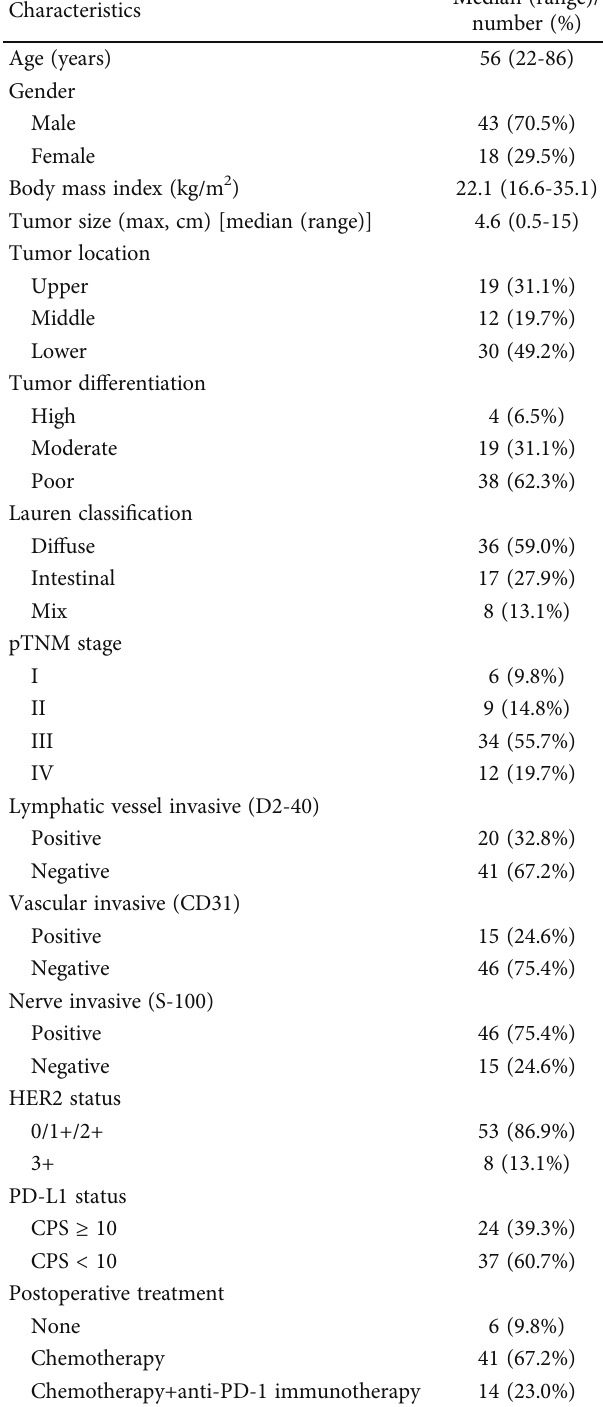
Table 1: Baseline characteristics of the study subjects ( n = 61 ).